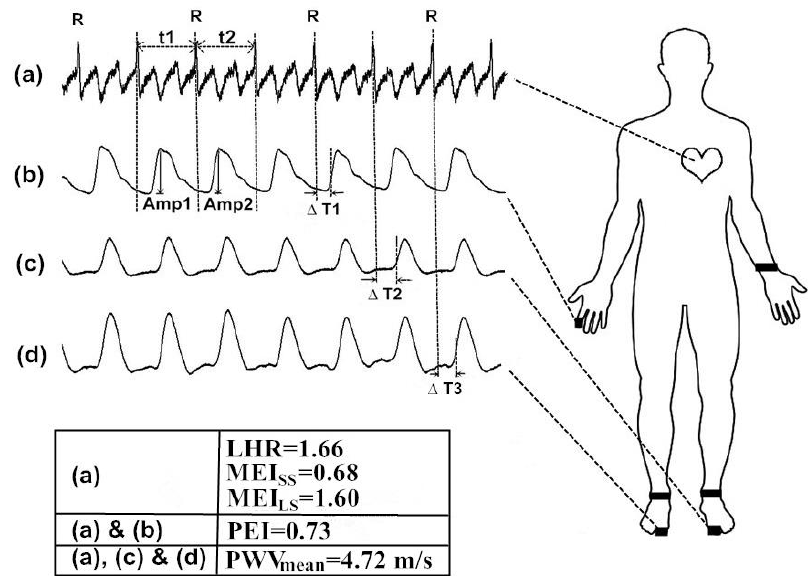
Figure 1. Schematic illustration of the measurements of six-channel electrocardiogram-based pulse wave velocity (ECG-PWV). The ECG and digital volume pulses (DVP) signals from one representative female subject in Group 1 with age of 44 and HbA1c of 5.1%. With ( a ) the R wave on Lead II of ECG, three parameters (i.e., low-/high- frequency power ratio (LHR), small-scale multiscale entropy index (MEI SS ), and large-scale multiscale entropy index (MEI LS ) were computed using only the RRI dataset. The synchronized ECGs ( a ) and the right index finger photoplethysmography (PPG) signals ( b ) were obtained for percussion entropy index (PEI) computation. With (a) the R wave on Lead II as a reference point, the time differences (ΔT 2 ( c ) and ΔT 3 ( d )) for the second toe were obtained. The PWV mean was calculated by dividing the distances from different points of reference (L) with ΔT (i.e., PWV = L/ΔT). The PWV mean , in the evaluation of the degree of atherosclerosis in the lower extremity of the body, was obtained by averaging the PWV values from both sides of the foot.